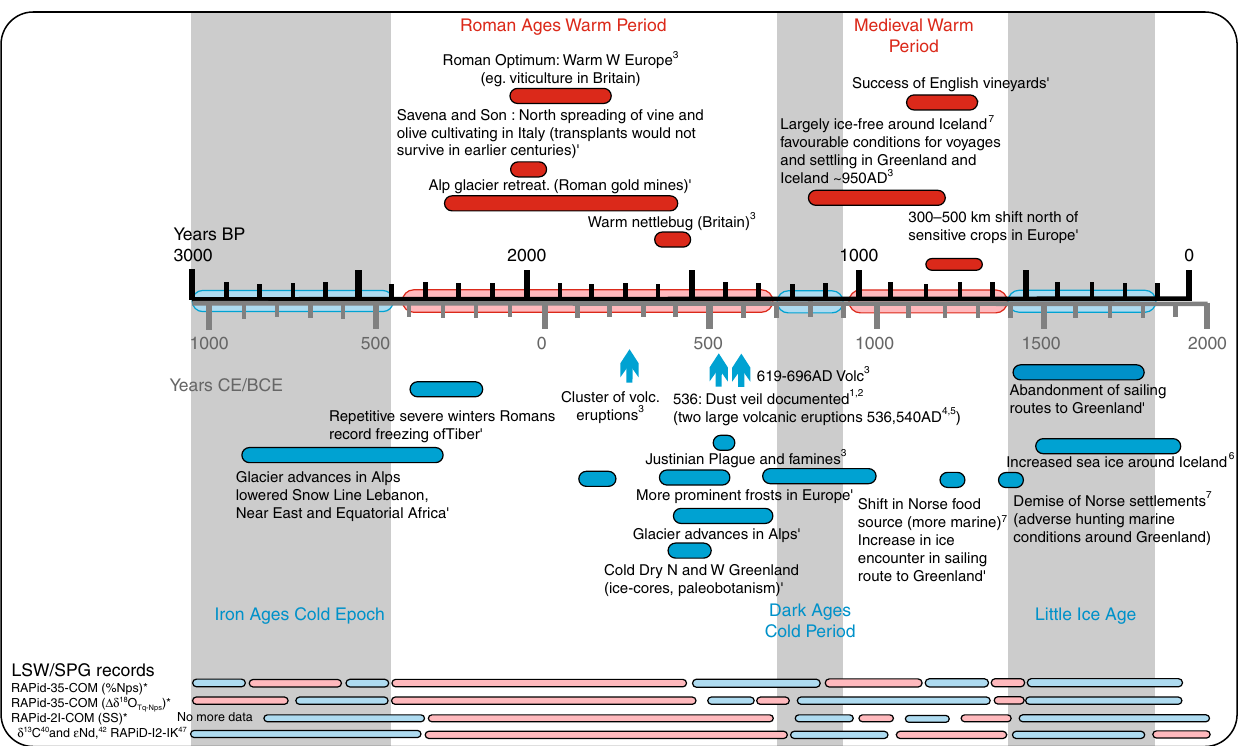
Fig. 4 Schematic timeline highlighting historic records of climate variability in Europe. Red and blue lines denote the time-span for the evidence for warm and cold periods, respectively. Ages are in years BP (black) and years CE/BCE (grey). This information has been extracted from several publications indicated by the superscript in the annotations: 1. ref. 68 and references herein; 2. ref. 69 ; 3. ref. 70 and references herein; 4. ref. 71 ; 5. ref. 72 ; 6. ref. 73 ; 7. ref. 74 The cold and warm periods established through the glacier advances and retreats used as a framework for the study of these centennial events 49 are found within the axis of the timeline and highlighted by the vertical grey bars (consistent with Figs. 2 and 3). The marine paleoceanographic reconstructions for the LSW and Subpolar Gyre (SPG) presented in Fig. 3 are represented in blue and pink horizontal bars indicating time intervals below and above average values of the records for the last 3000 years for weaker and stronger LSW/SPG, respectively. For more information on the agreement with terrestrial proxy records and historical events see Supplementary Fig.